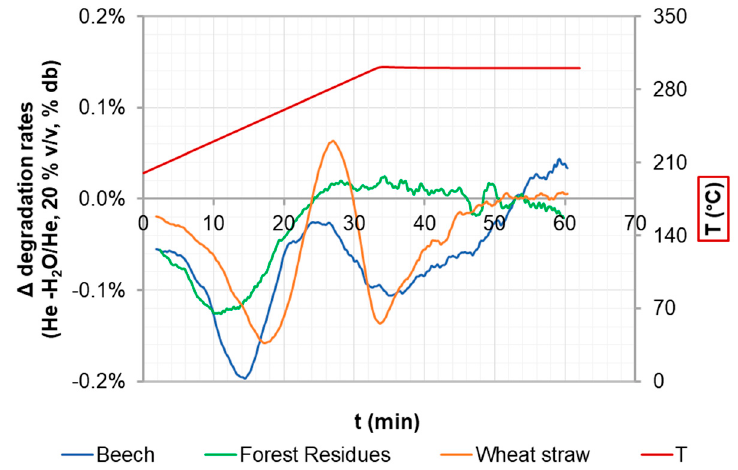
Figure 7. Instantaneous difference in degradation rate versus time and temperature from TGA results of the torrefaction of beech, forest residues and wheat straw under dry (He, 100% v/v ) and moist (H 2 O/He, 20% v/v ) atmospheres.